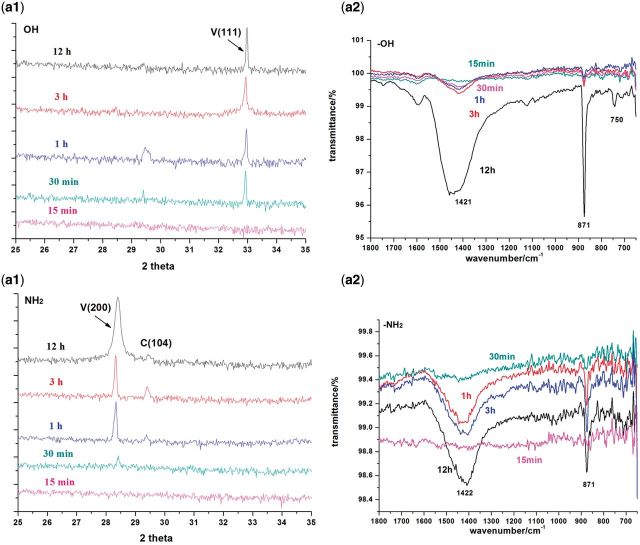
XRD patterns and FTIR-ATR spectra of CaCO3 formed on −OH (a1, a2) and −NH2 (b1, b2) surfaces at 15, 30 min, 1, 3 and 12 h. C, calcite; V, vaterite.